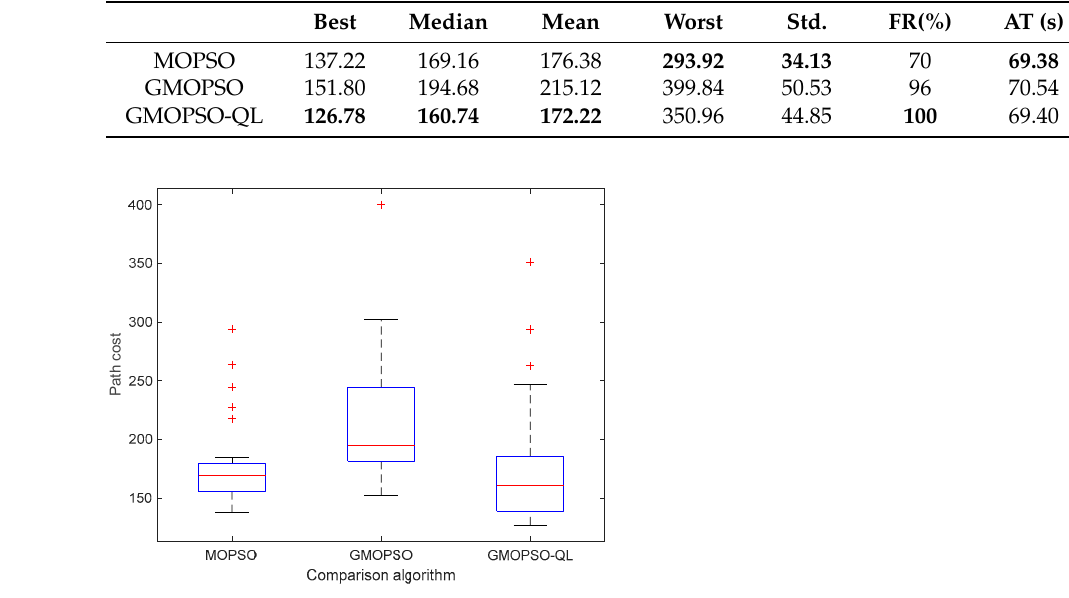
Figure 7. The boxplot of statistical results in Case 1.